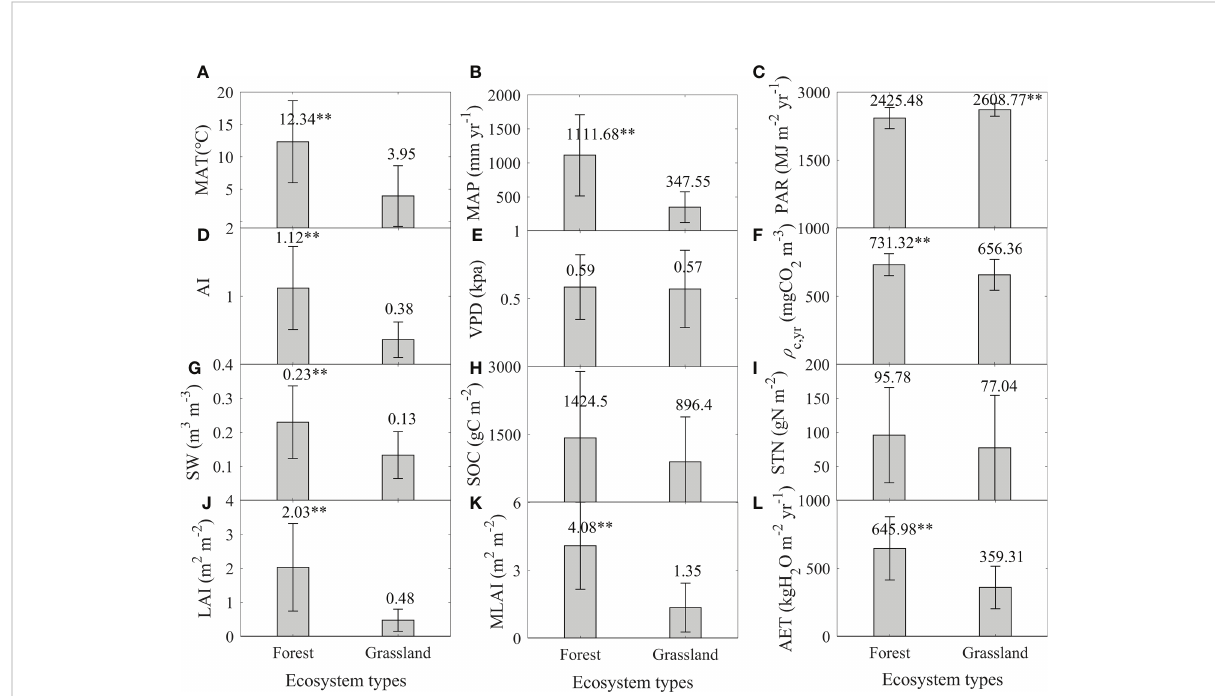
FIGURE 2 Differences in environmental factors and annual evapotranspiration (AET, L ) between forests and grasslands. Environmental factors include mean annual air temperature (MAT, A ), mean annual precipitation (MAP, B ), annual total photosynthetic effective radiation (PAR, C ), aridity index (AI, D ), annual mean water vapor pressure difference (VPD, E ), annual mean CO 2 mass concentration ( r c,yr , F ), soil water content (SW, G ), soil organic carbon content (SOC, H ), soil total nitrogen content (STN, I ), mean annual leaf area index (LAI, J ), and maximum leaf area index (MLAI, K ). *P<.05, **P<.01,